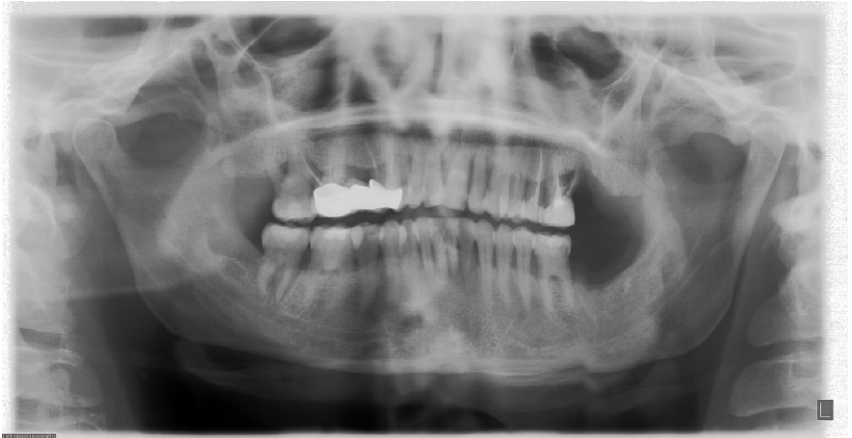
on the contralateral mandibular ramus/third molar area in the form of an artefact.